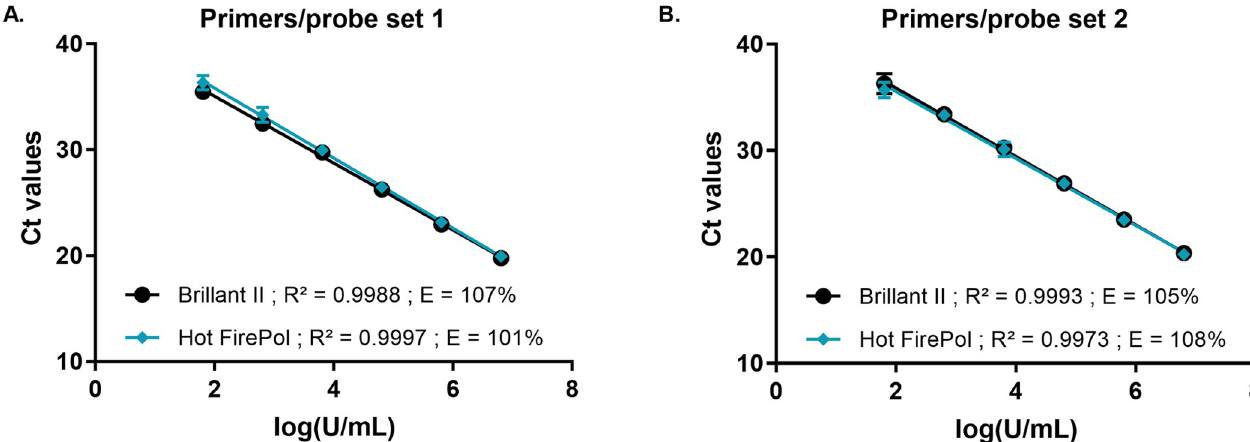
Fig 4. Comparison of qPCR mixes and primers/probe sets for sensitivity and efficiency. Serial 10-fold dilution from 6.4x10 6 U/mL to 6.4x10 0 U/mL of M . ulcerans DNA. The standard curve was generated by a linear regression of the threshold cycle (Ct) against the logarithm of M . ulcerans DNA concentration. Each 10-fold dilution was performed in duplicate for n = 3 experiments, one standard deviation (SD) is shown. (A) Primers/probe set 1: Brillant II ( y = − 3.16 x + 41.37); Hot FirePol ( y = − 3.307 x + 42.44). (B) Primers/probe set 2: Brillant II ( y = − 3.217 x + 42.31); Hot FirePol ( y = − 3.147 x +